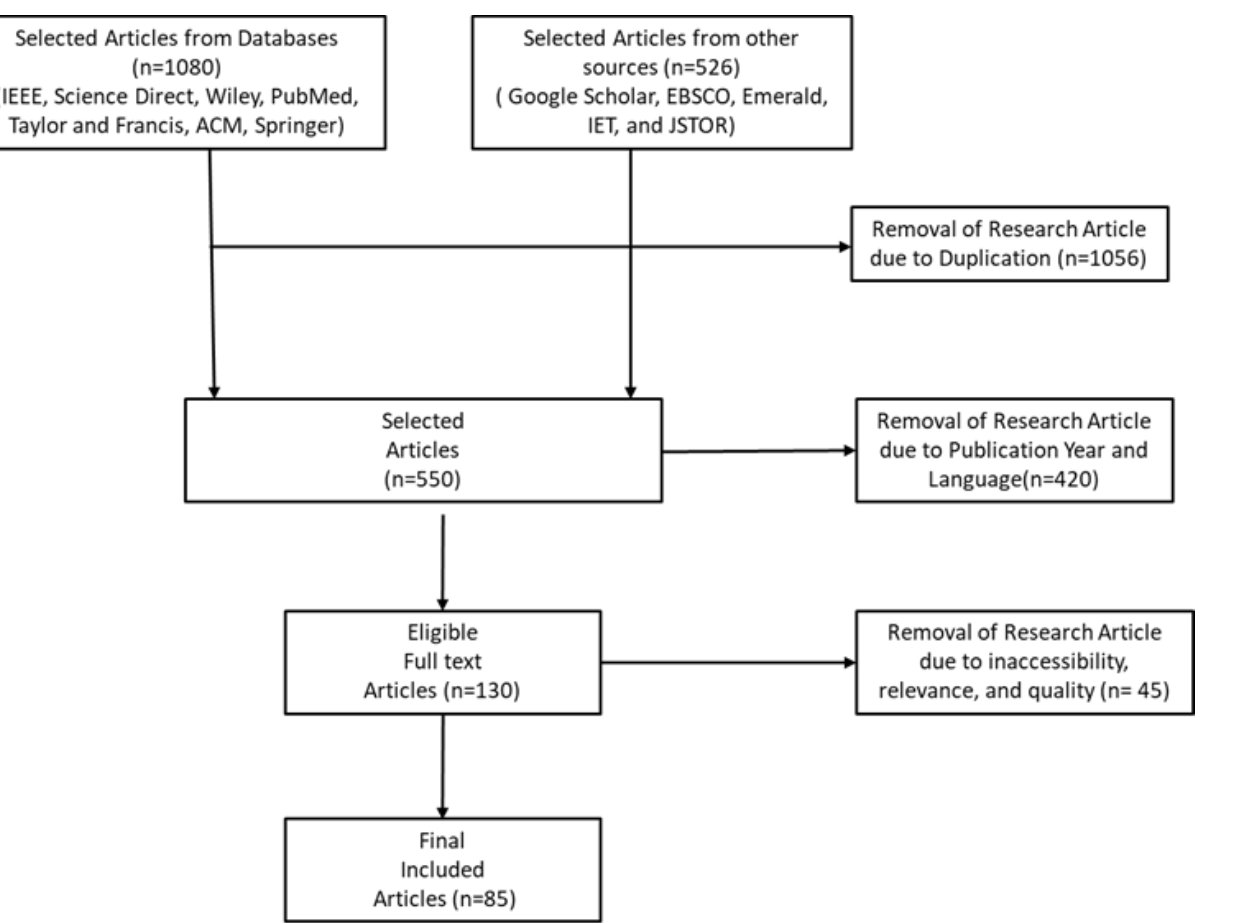
Figure 1. PRISMA flowchart of the study methodology.